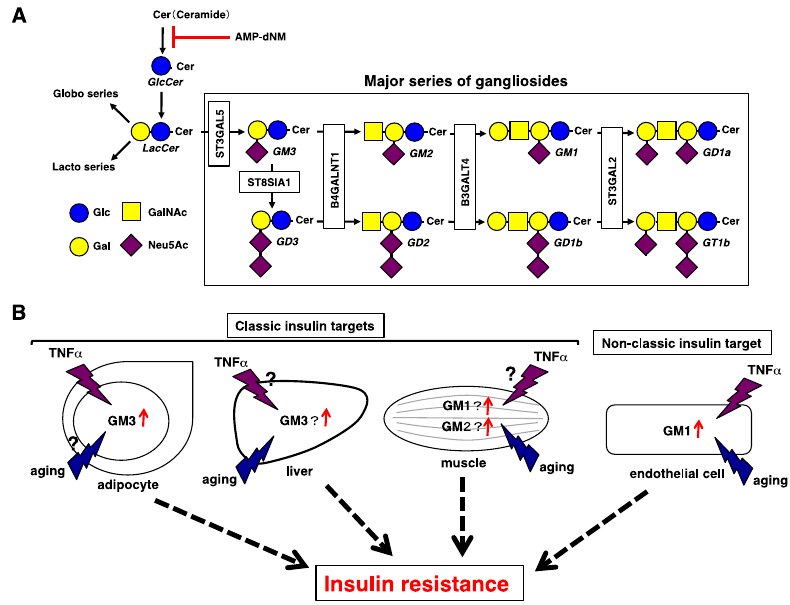
Figure 1. Insulin resistance mediated by gangliosides. ( A ) Pathways of glycolipids and glycosyltransferases contributing to each ganglioside synthetic pathway. Pathways of the major gangliosides are shown within the rectangle. AMP-dNM is a specific inhibitor of glucosylceramide synthase. Symbols are according to Reference [22]. Glc, Glucose; Gal, Galactose; GalNAc, N -acetylgalactosamine; Neu5Ac, N -acetylneuraminic acid. ( B ) Gangliosides involved in insulin